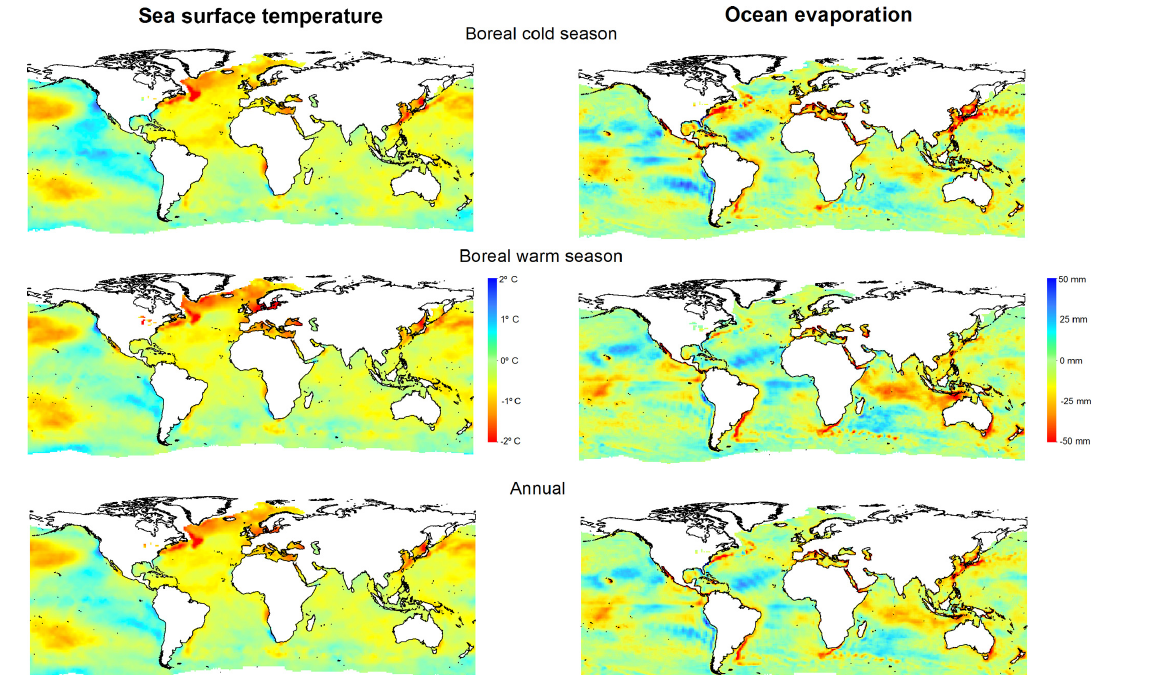
Figure 13. Annual and seasonal magnitude of change of SST and OAFlux oceanic evaporation for